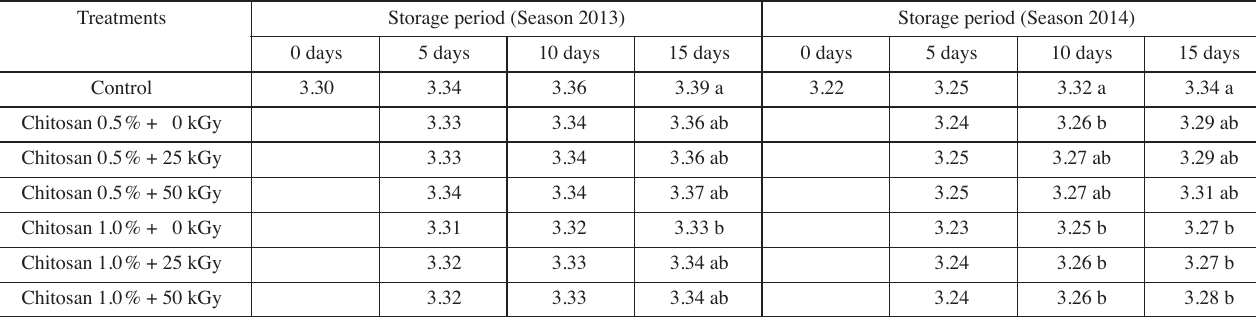
Tab. 2: Effect of irradiated and unirradiated chitosan on arils juice pH value during cold storage.